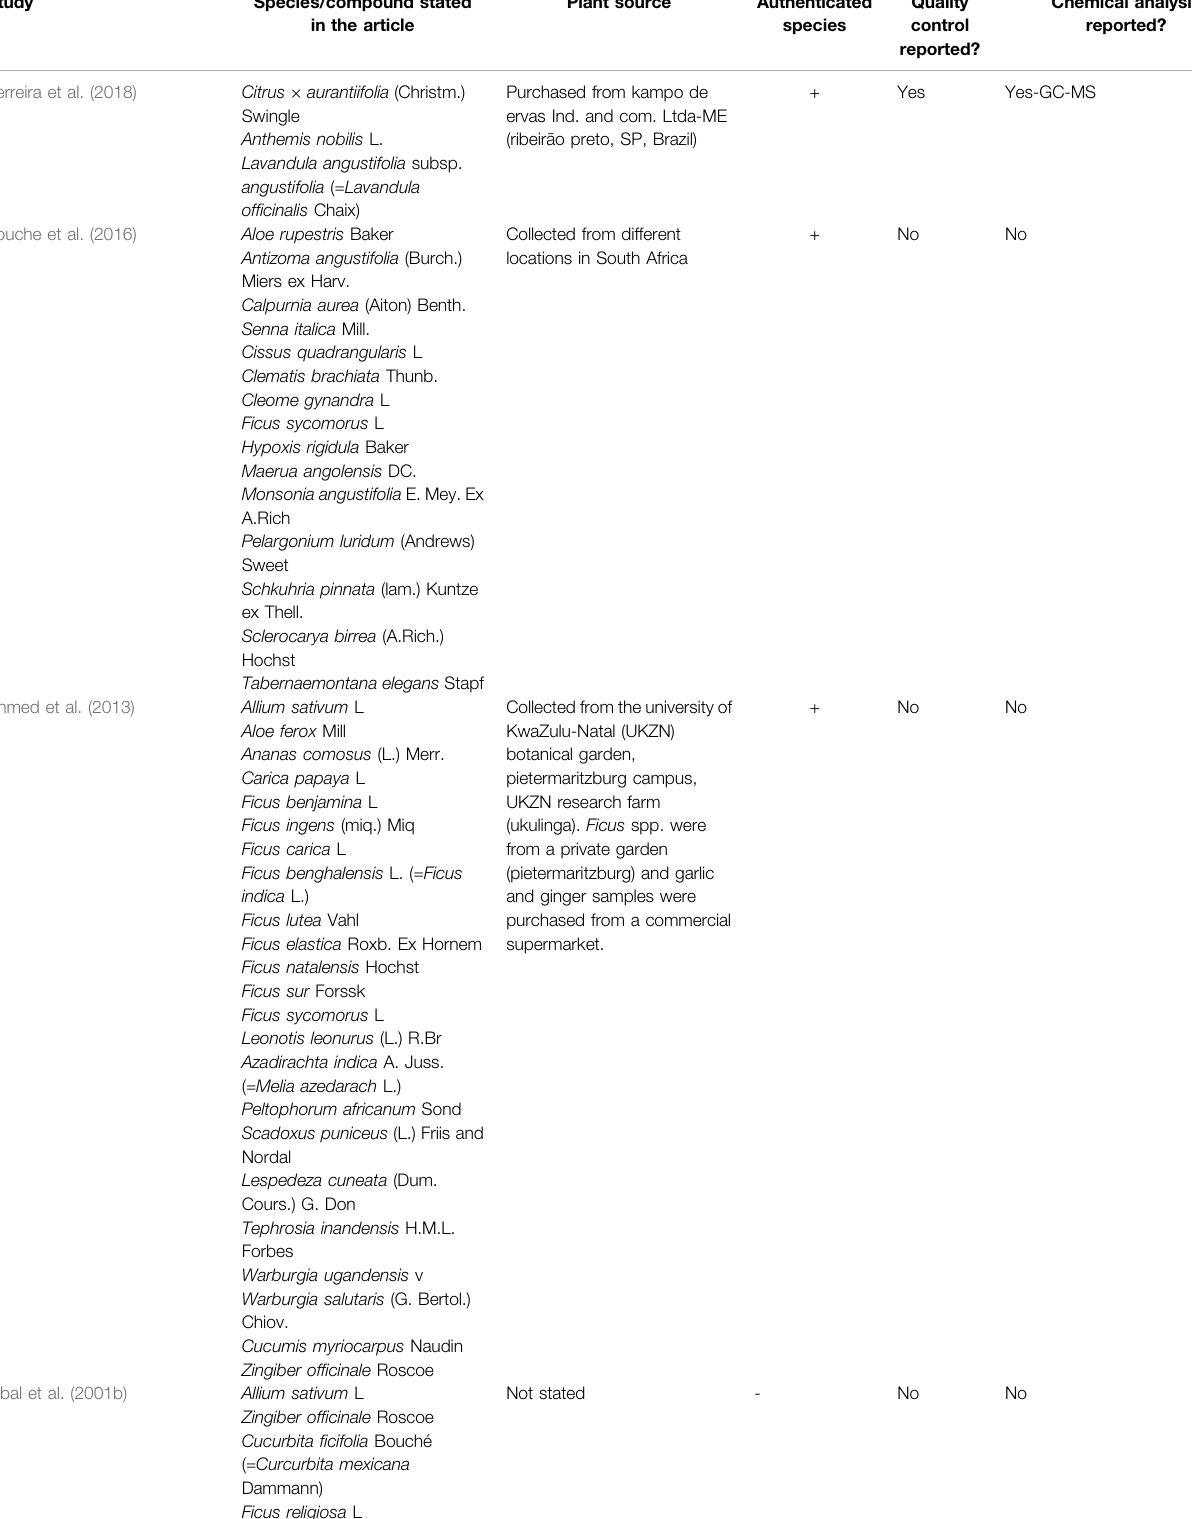
TABLE 1 | ( Continued ) Quality assessment of the articles selected for this systematic